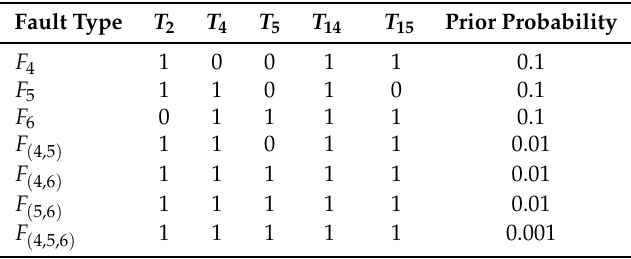
Table 8. Multiple fault dependency matrix of the system in Experiment 1.